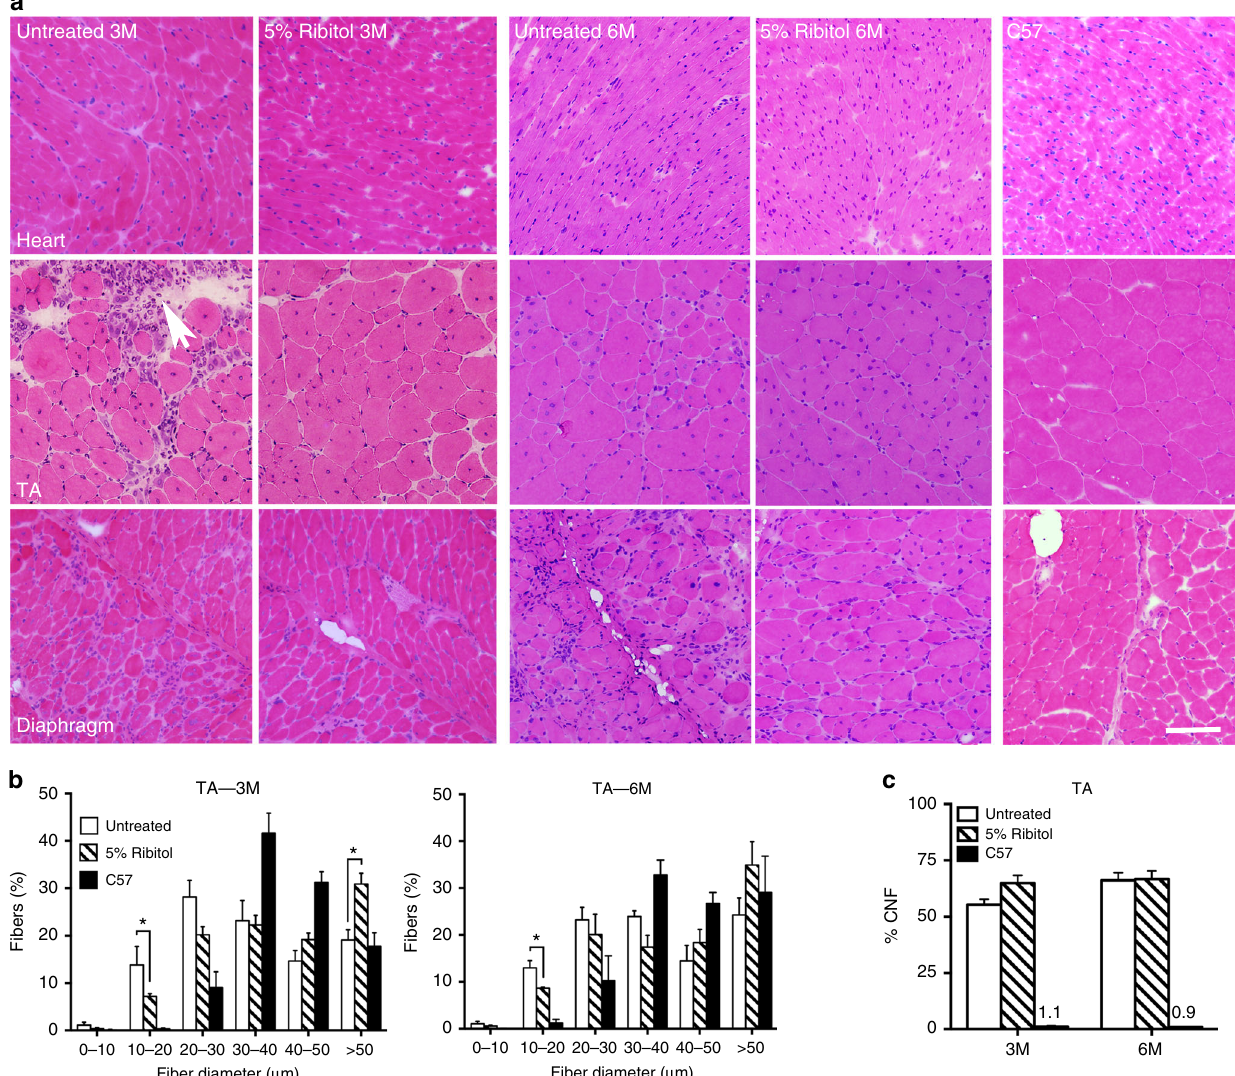
Fig. 4 Histopathology of muscle tissues from ribitol-treated P448L mice. Seven-week-old P448L mice were given drinking water only, or drinking water supplemented with 5% ribitol for either 3 months (3M) or 6 months (6M). a H&E staining of heart, tibialis anterior (TA), and diaphragm tissues from untreated (untreated 3M and untreated 6M) or ribitol-treated (5% ribitol 3M and 5% ribitol 6M) P448L mice, and C57 mice. Arrow indicates areas of heavy in fi ltration in the control TA muscle. Scale bar, 50 μ m. b Fiber size distribution of TA muscles of either untreated ( n = 3) or ribitol-treated ( n = 6) P448L mutant mice, and C57 ( n = 3) mice. c Percentage of CNF in TA muscles of P448L mice treated with 5% ribitol for 3M ( n = 6) and 6M ( n = 4), or aged-matched untreated ( n = 3) P448L mice and C57 ( n = 3) mice. Error bars represent mean ± SEM. Unpaired t test, * p ≤